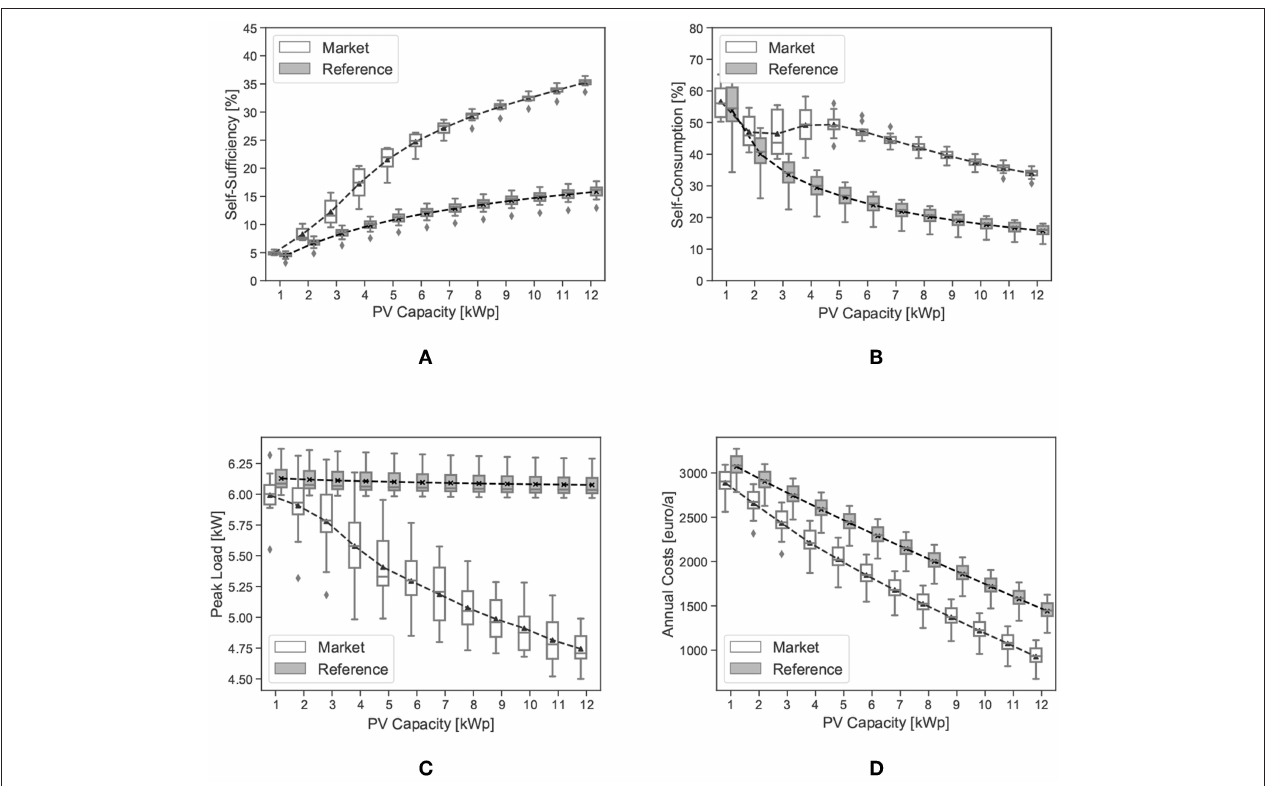
FIGURE 8 | Metrics of the scenario subgroup B2, (A) self-sufficiency, (B) self-consumption, (C) peak load, (D) annual